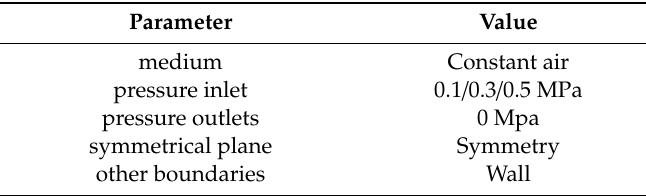
Figure 5. Model boundary conditions. Table 2. Boundary conditions. Table 2. Boundary conditions.